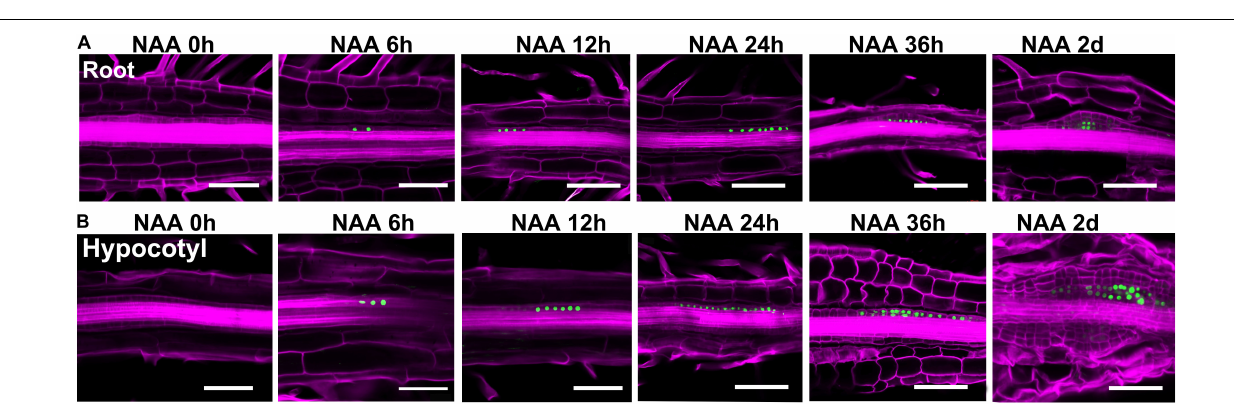
FIGURE 5 | Expression patterns of WOX11 revealed by the pWOX11:H2B-eGFP lines during shoot regeneration. (A,B) Illustrate direct and indirect regeneration processes, respectively. Hours or days for NAA-treatment are indicated on top of each panel. Scale bars represent 50 µ